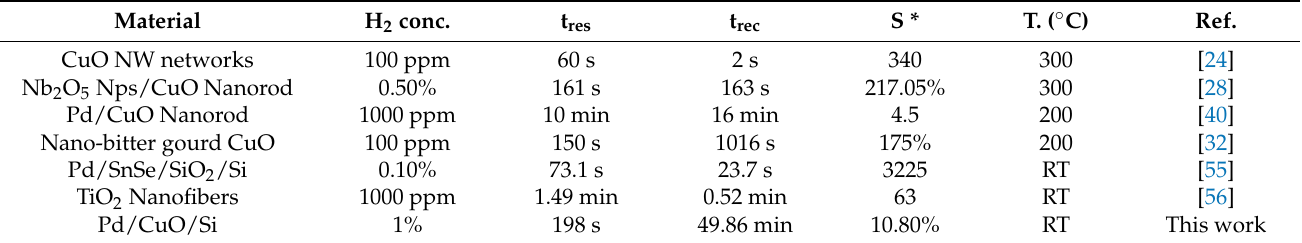
Table 2. Comparison of performance parameters with reported